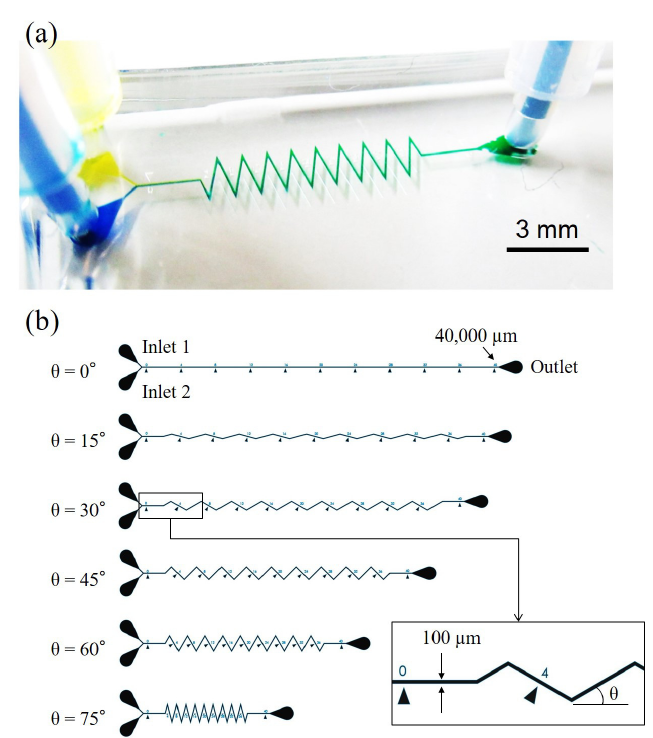
Figure 1. An overview of a zigzag mixing channel and zigzag angles. ( a ) A photo of the microfluidic chip in experiments. ( b ) Designs of microfluidic mixing channel with six different zigzag